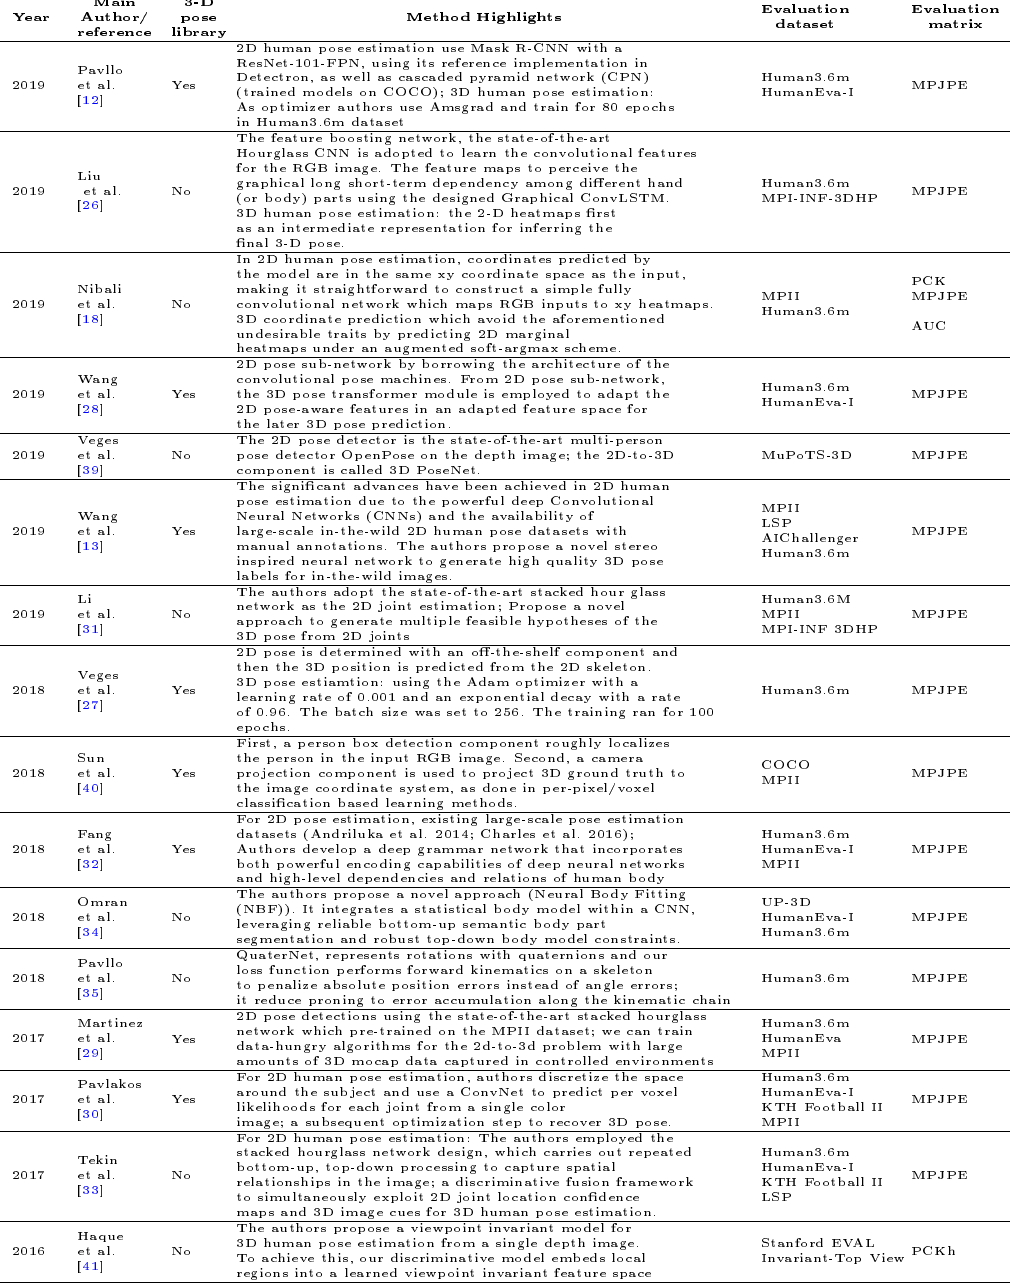
Tab. 2: Survey: 3-D human pose estimation from a single